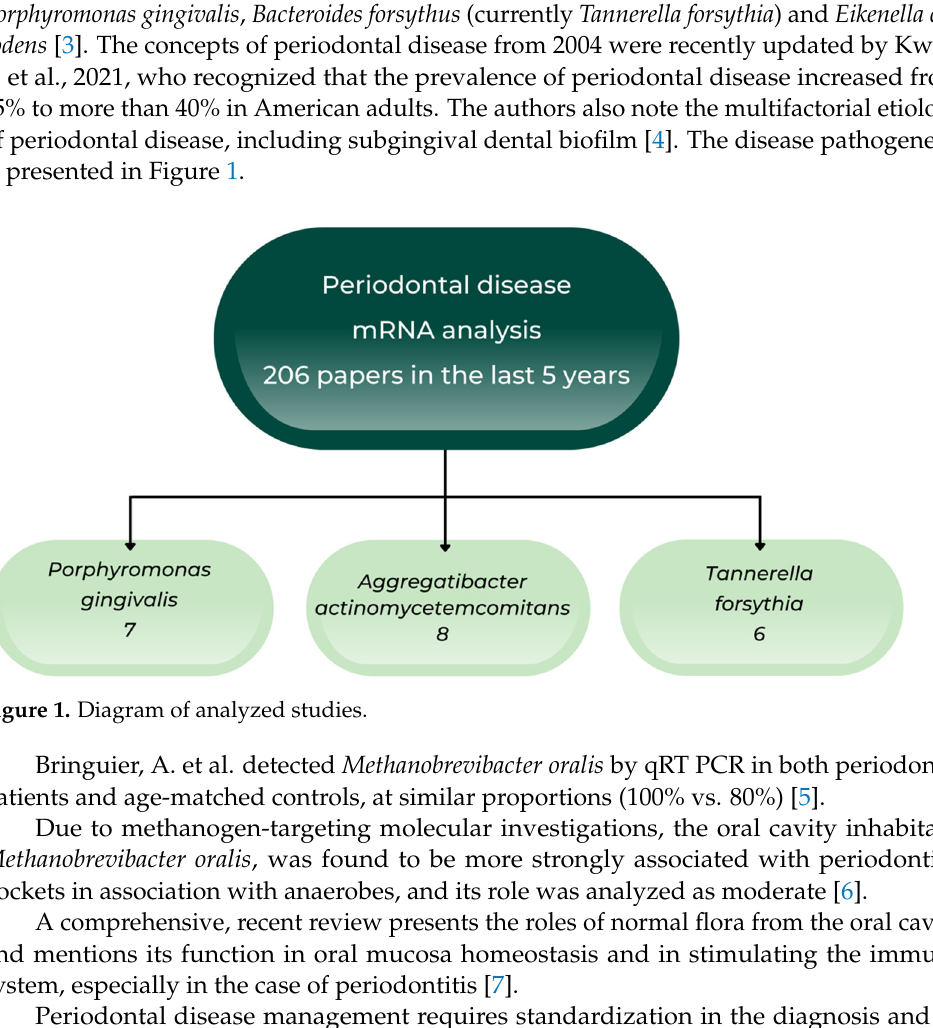
Figure 2. Periodontal and gingival health [14].